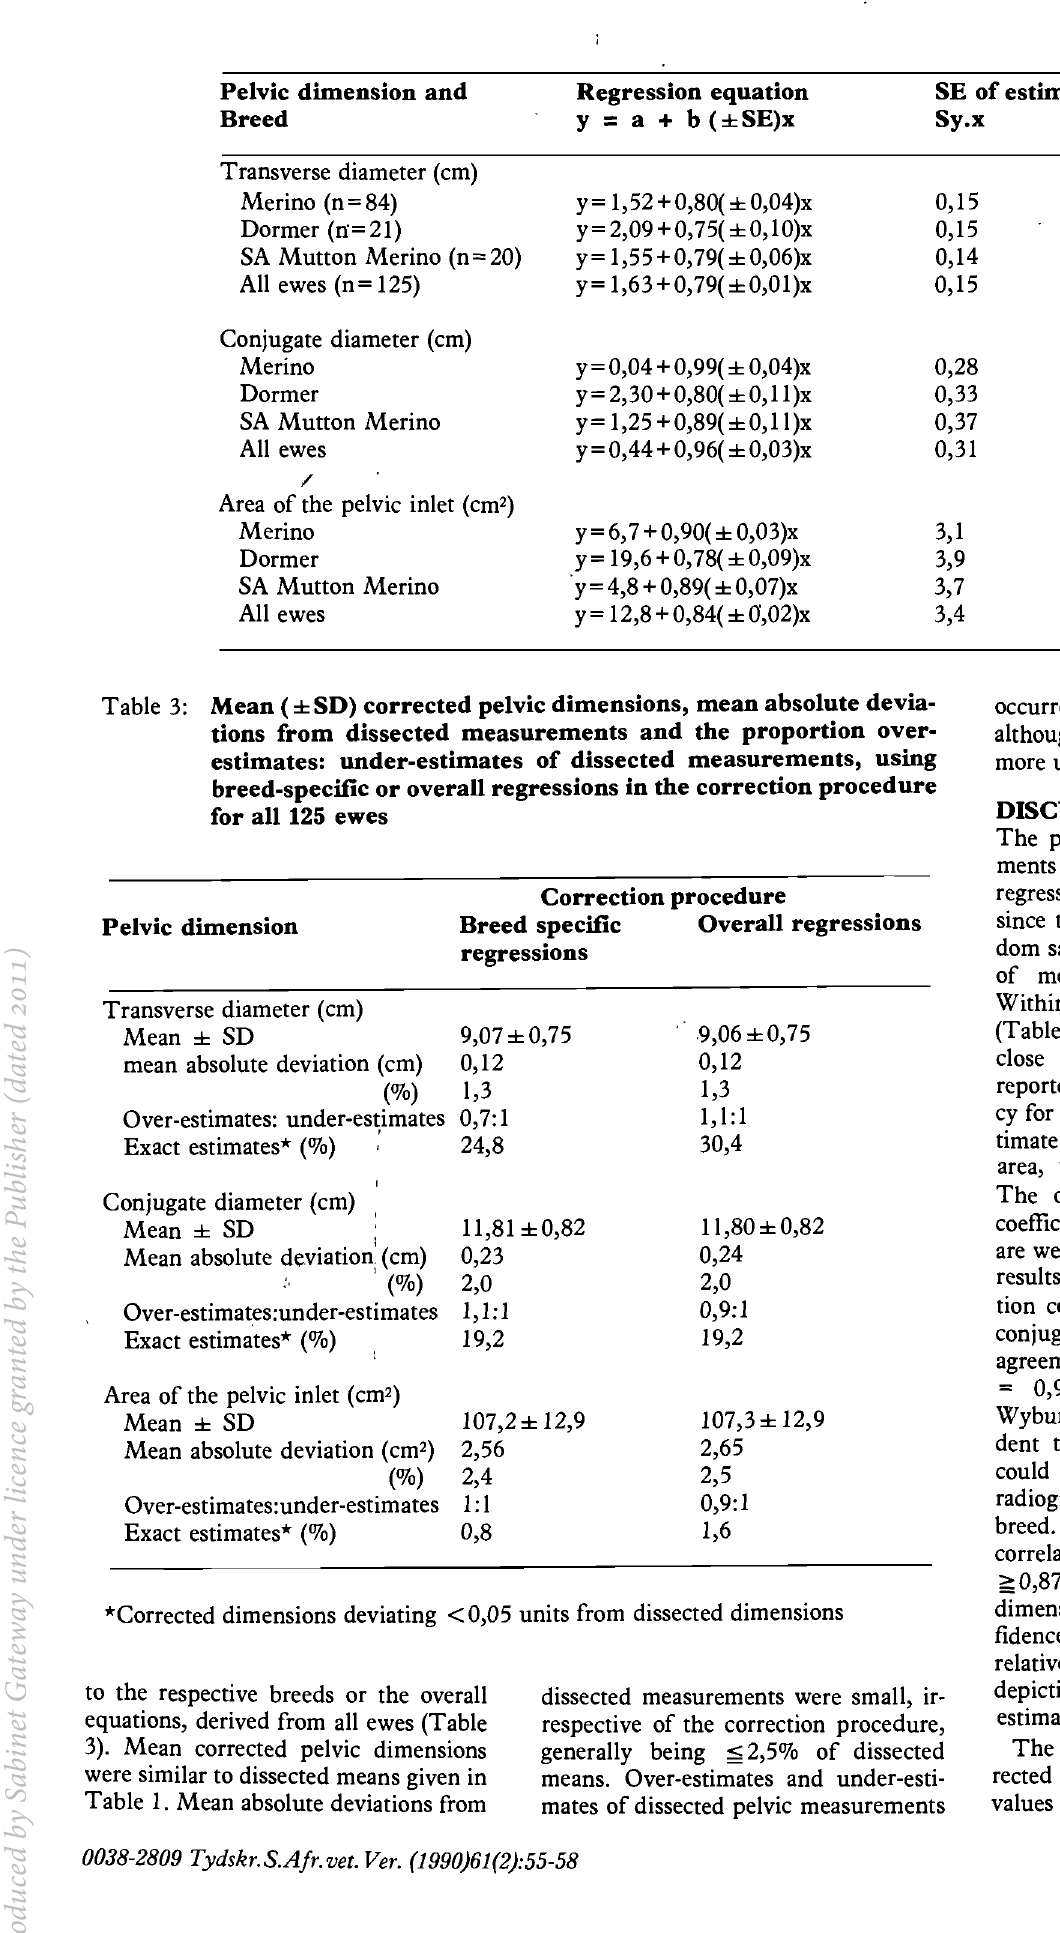
Pelvic dimension and